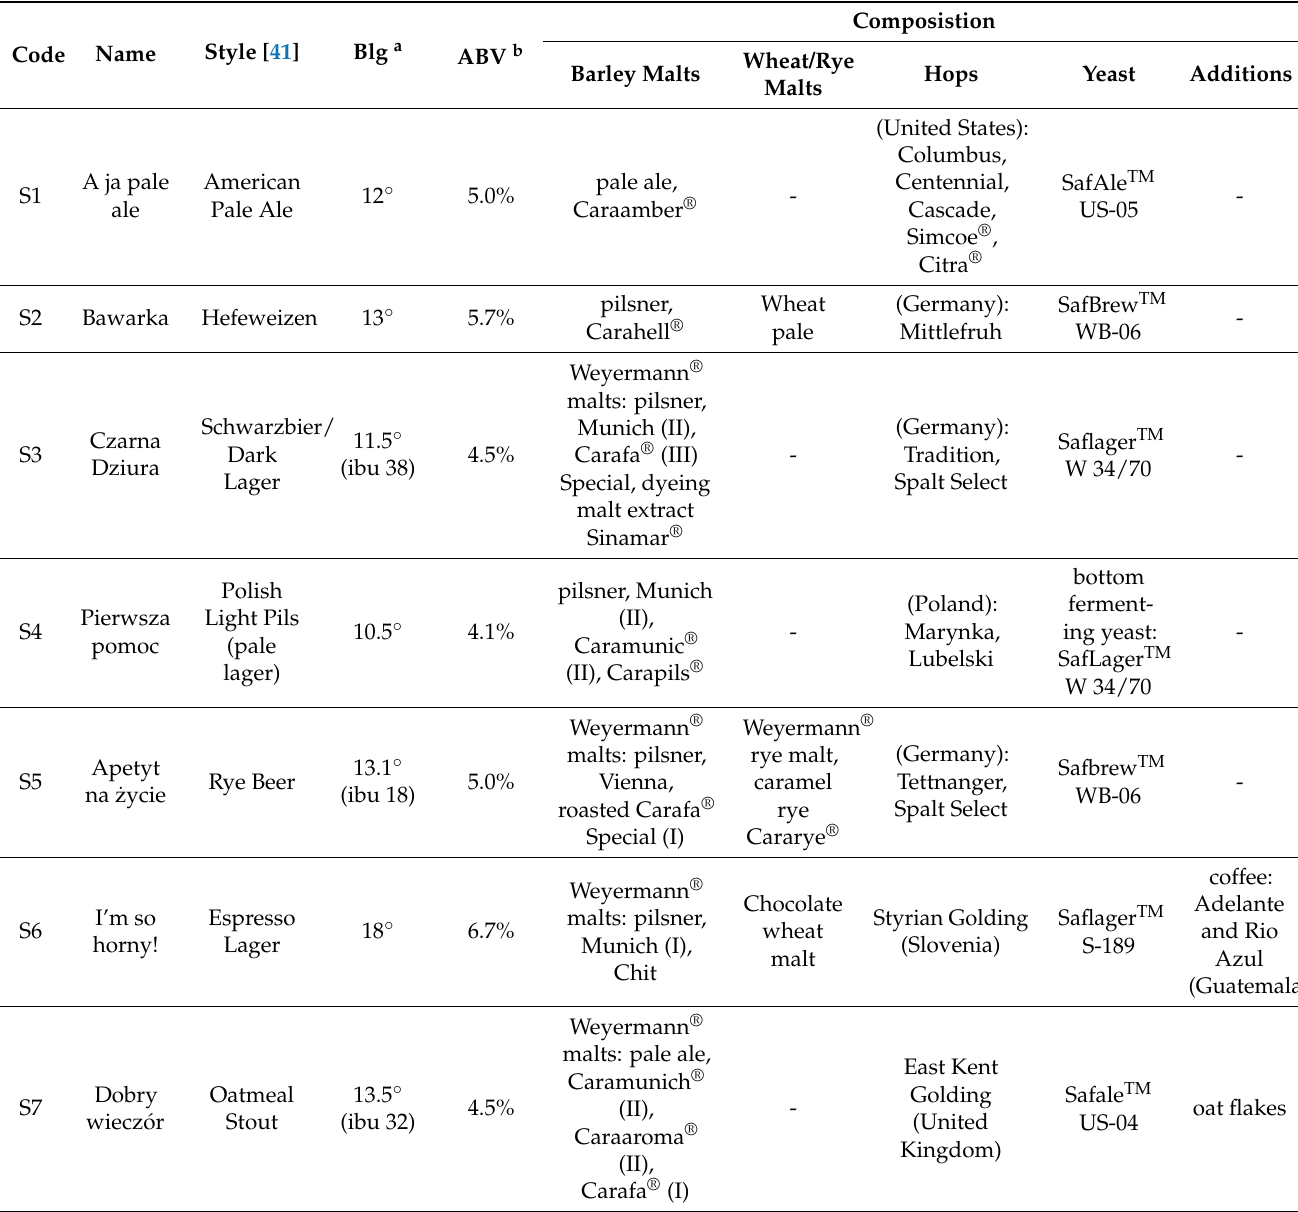
Table 2. Detailed description of analyzed